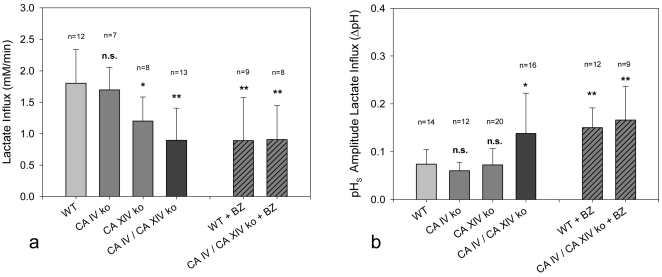
Lactate influxes and amplitudes of surface pH transients.Influxes (a) and amplitudes (b) are shown for WT fibers and for fibers lacking CA IV, CA XIV or both. On the right, both figures show the effects of the extracellular CA inhibitor benzolamide.